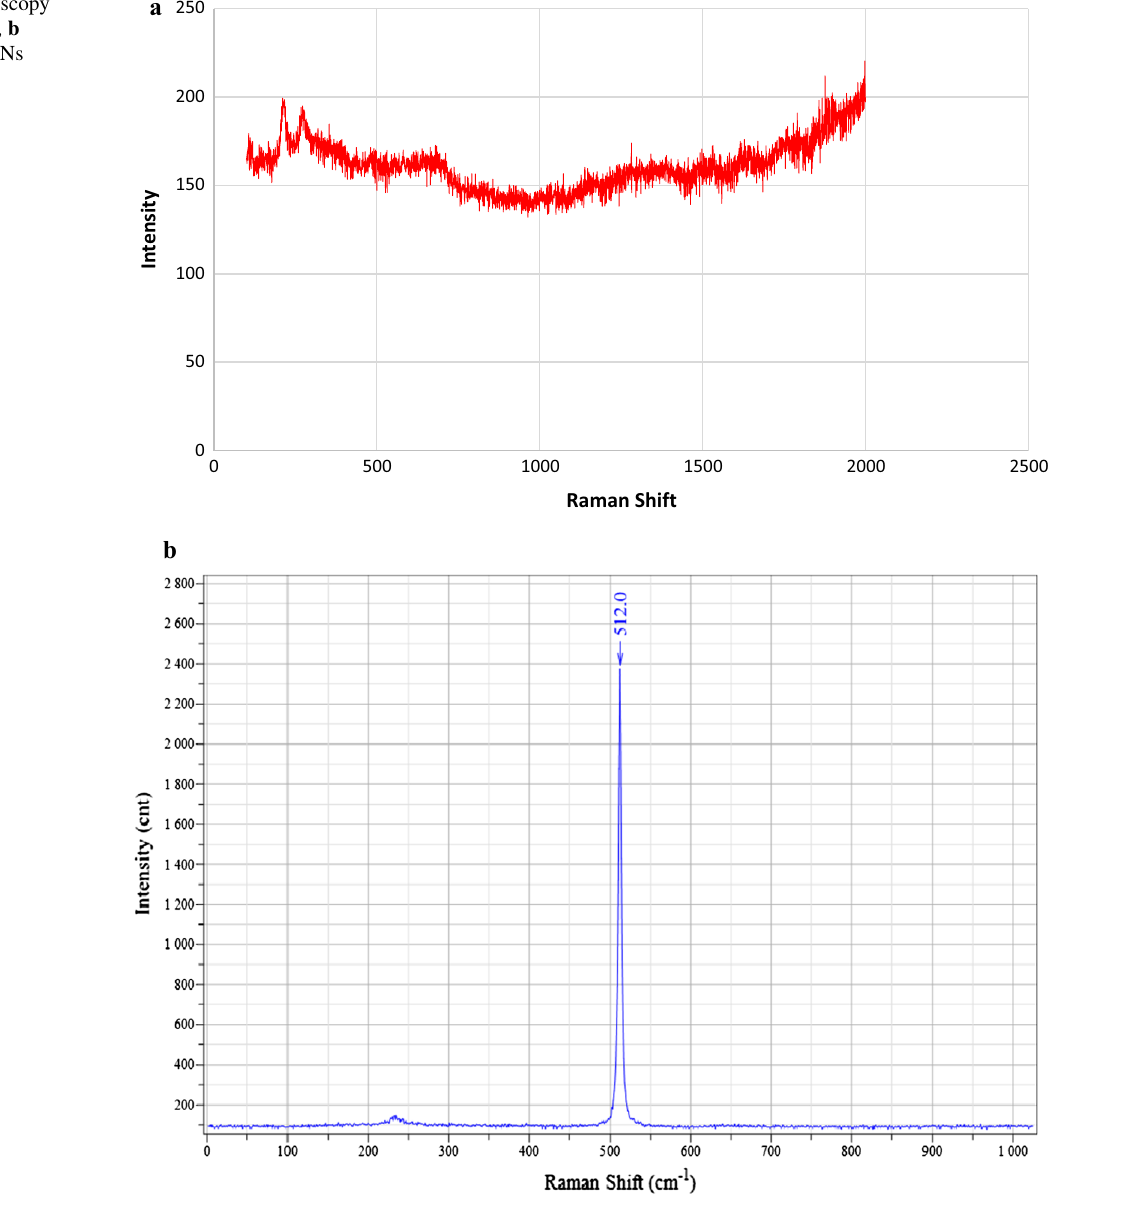
Fig. 7 Raman spectroscopy analysis of a SPIONs, b chitosan-coated